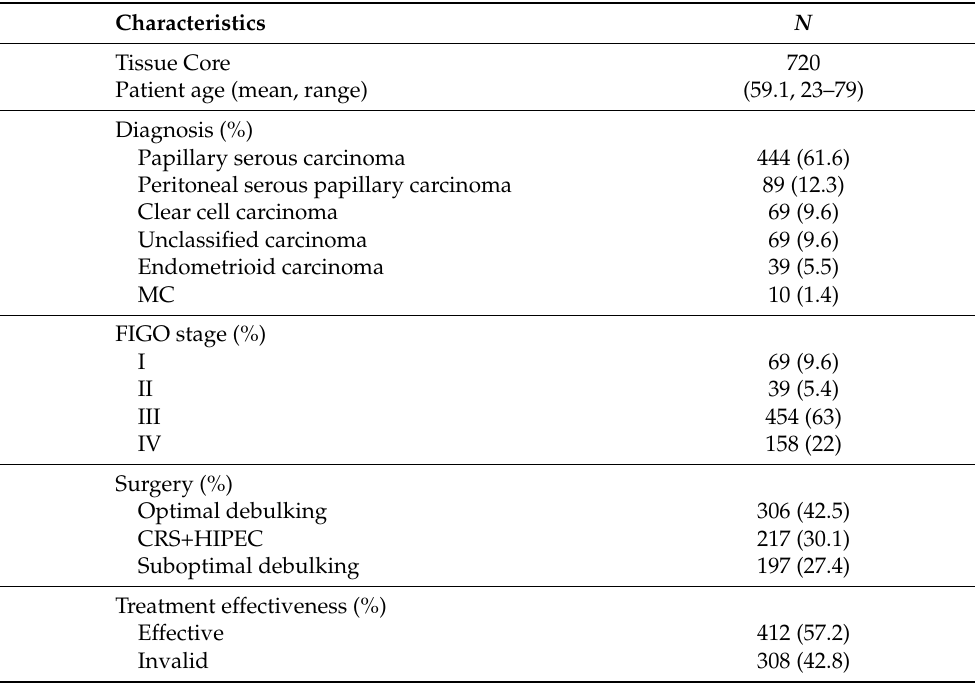
Table 1. Baseline characteristics of data.